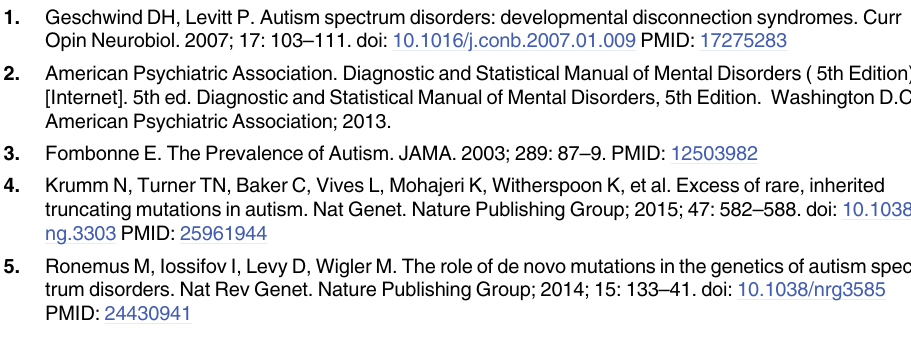
S6 Table. Gene list with centrality measures of the biggest connected component of the network of the male sibling. S7 Table. Gene list with centrality measures of the biggest connected component of the network of the female